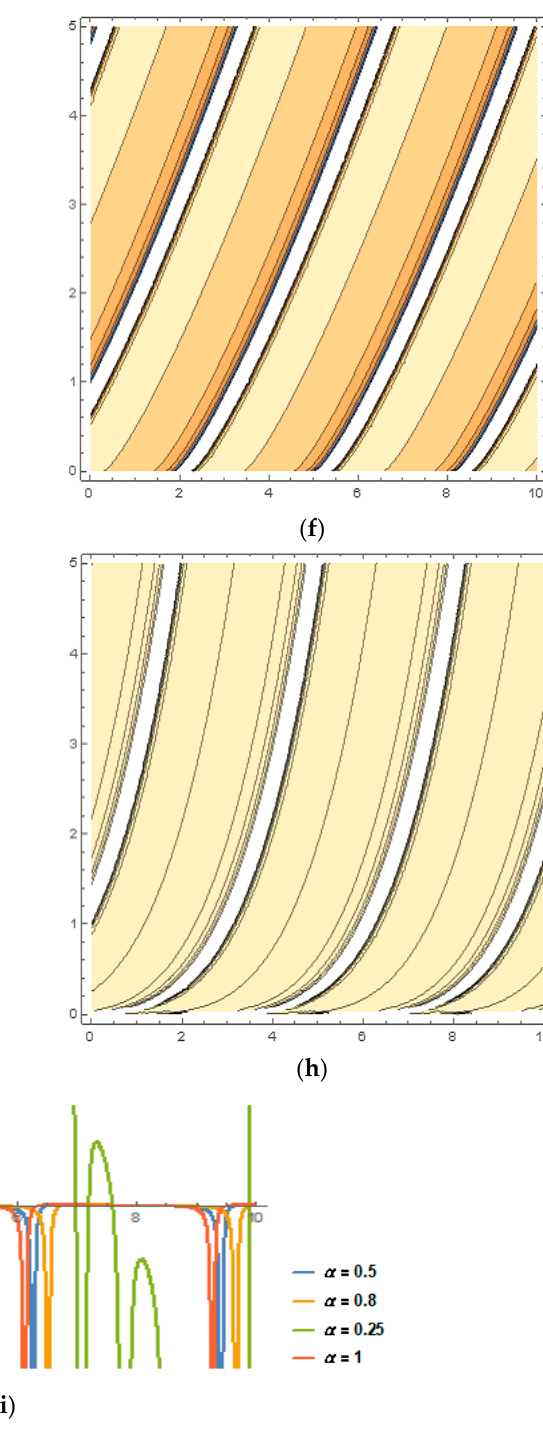
Figure 3. For Equation (30), ( a – d )with 0 ≤ x ≤ 10 and 0 ≤ t ≤ 5 denote the 3D profiles, ( e – h ) express the contour profiles for 0 ≤ x ≤ 10 and 0 ≤ t ≤ 5, and ( i ) indicates the 2D representation of a range of values of α . ( a ) α = 1, ( b ) α = 0.8, ( c ) α = 0.5, ( d ) α = 0.25, ( e ) α = 1, ( f ) α = 0.8, ( g ) α = 0.5, and ( h ) α =